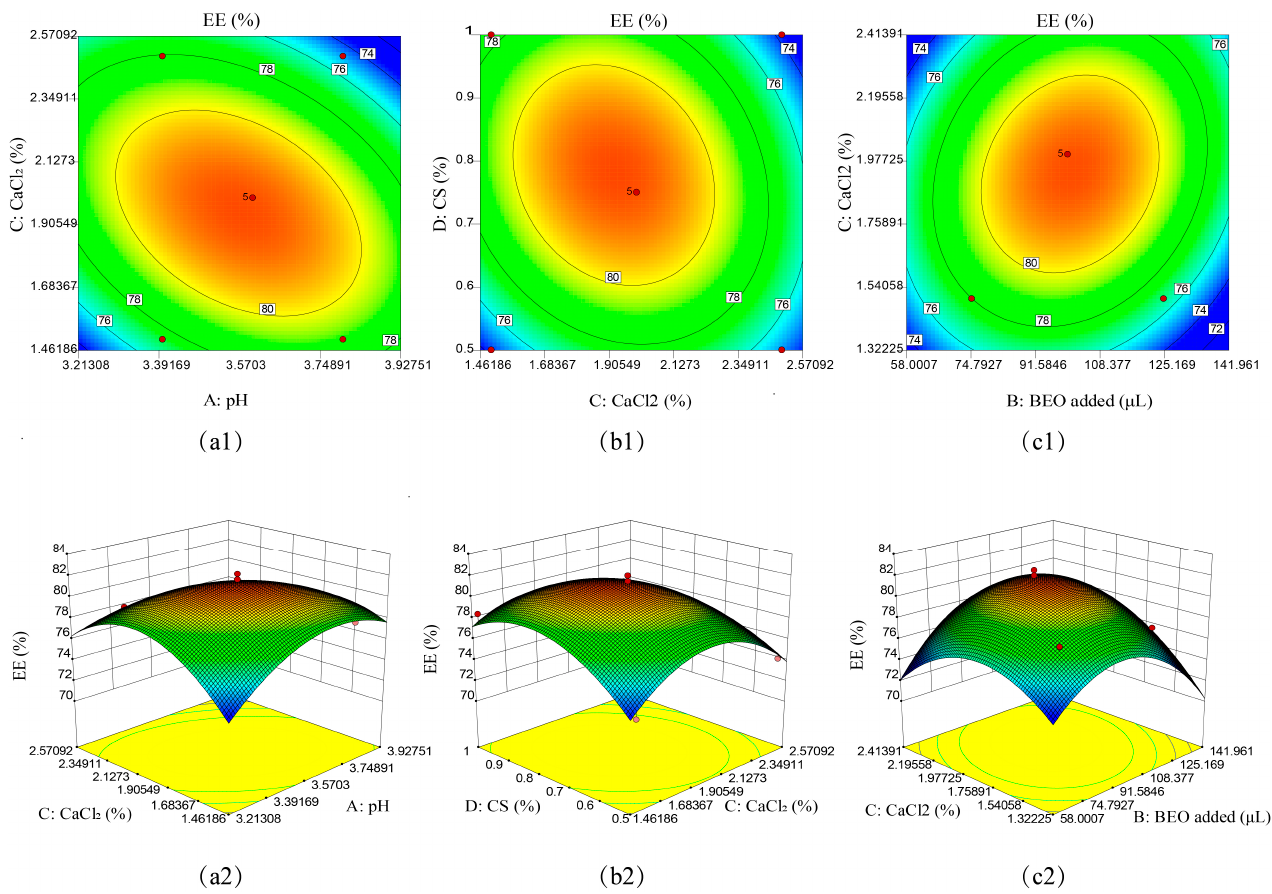
Figure 2. Response surface analysis diagram of the interaction of various experimental factors. The change in color from blue to red indicates a gradual increase in the interaction between the factors. The faster the change, the larger the slope, indicating the impact on the experimental results is more significant. ( a1 , a2 ): Interaction between pH Value and CaCl 2 concentration; ( b1 , b2 ): Interaction between CaCl 2 concentration and CS concentration; ( c1 , c2 ): Interaction between CaCl 2 concentration and the amount of BEO added.